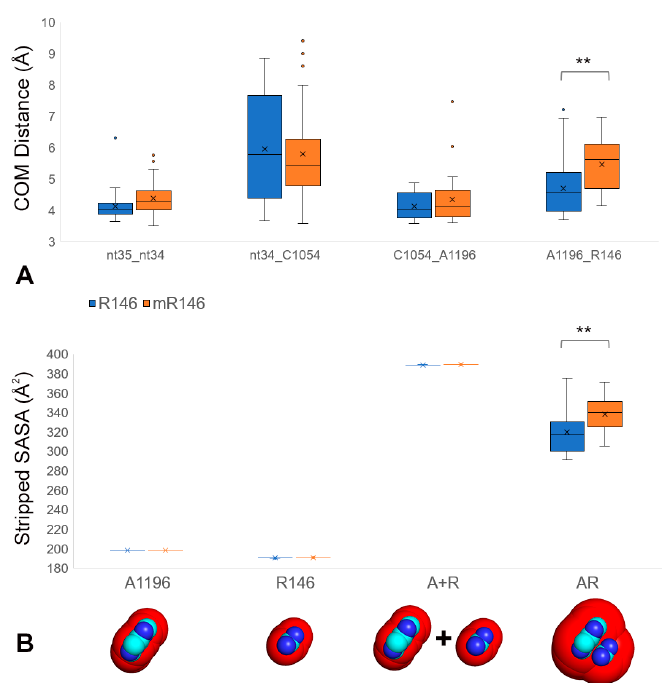
Figure 3. R146 methylation disrupts cation-pi stacking between R146 and A1196 in the CAR interface. ( A ) Stacking was assessed by measuring the distances between the centers of mass of the heavy atoms of bases or the guanidinium group of R146. Center of mass (COM) distances were measured for anticodon nt35 to nt34, anticodon nt34 to C1054, C1054 to A1196, and A1196 to R146, comparing the trajectories for methylated (mR146) and unmethylated (R146) guanidinium group. 30 trajectories were compared for each. The center of mass distance is significantly higher for mR146-A1196 compared to R146-A1196 ( t -test p < 0.01 **). ( B ) A stripped version of the solvent accessible surface area (SASA) protocol (see Materials and Methods) was used to assess solvent accessibility between (m)R146 and A1196 (in Å 2 ). The methylated guanidinium group had significantly higher solvent accessibility than unmethylated ( t -test p < 0.01 **), suggesting that the methylation disrupts cation-pi stacking with A1196.